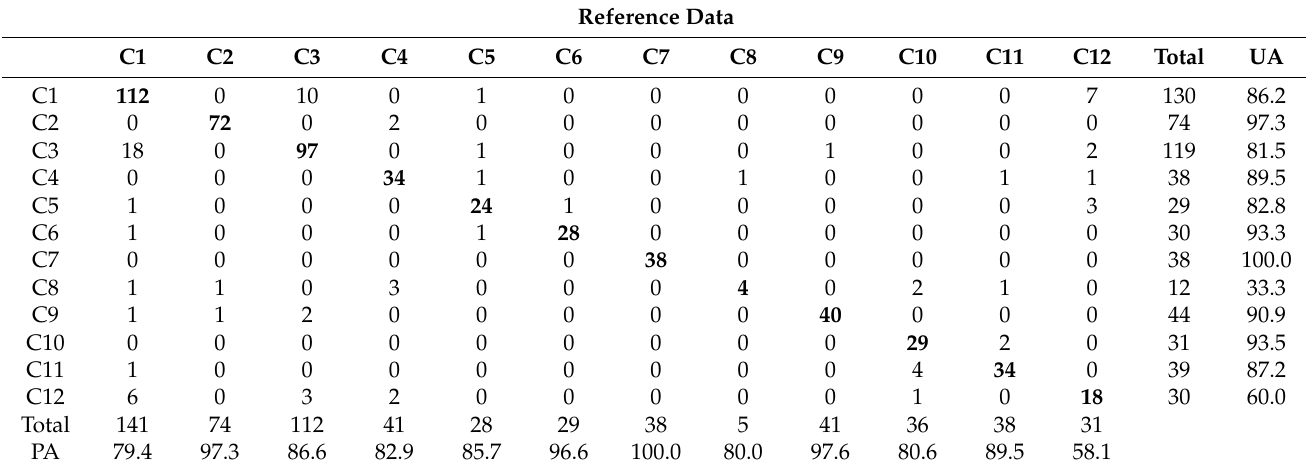
Table 7. Confusion matrix of M8 with only NDVI information (first